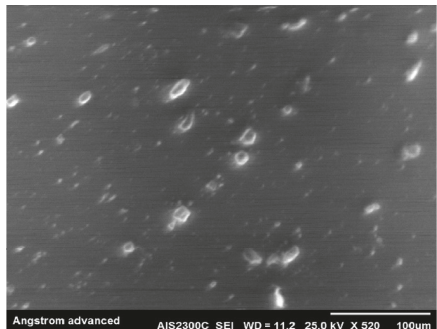
Figure 1: 1% by weight polyester powder group.